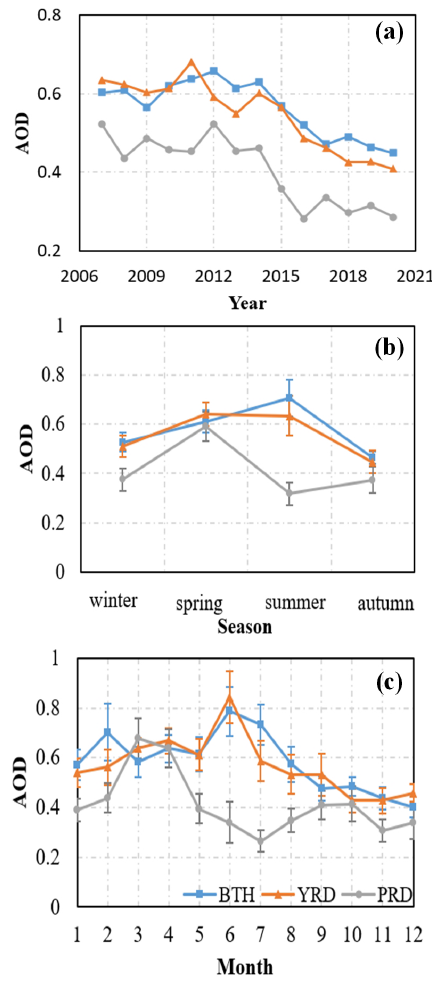
Figure 2. Annually (a) , seasonally (b) and monthly (c) averaged MODIS AOD over the three study regions. The data for the three regions are color